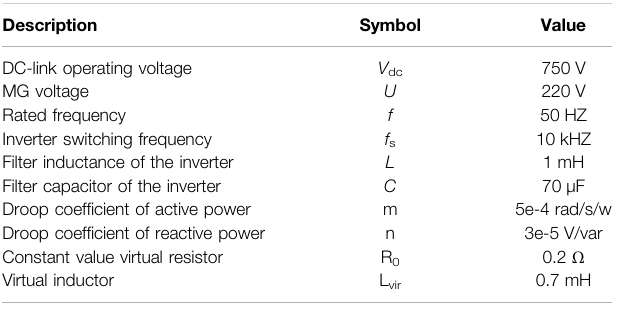
TABLE 1 | Main parameters of the VSI